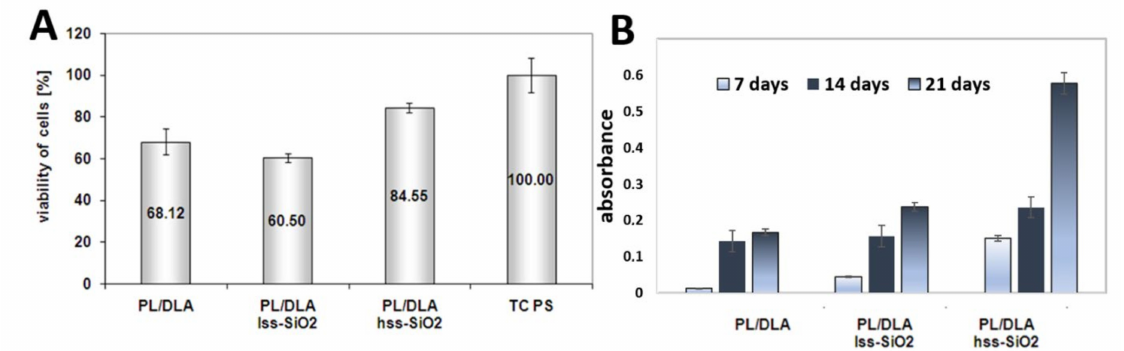
Figure 8. Viability of mesenchymal stem cells contacted with the nanocomposite membrane and the pure polymer membrane ( A ). TC PS was used as the reference sample. Alkaline phosphatase activity on PLDLA, PLDLA/lss-SiO 2 and PLDLA/hss-SiO 2 using MSCs on day 7, 14, and 21 ( B ).